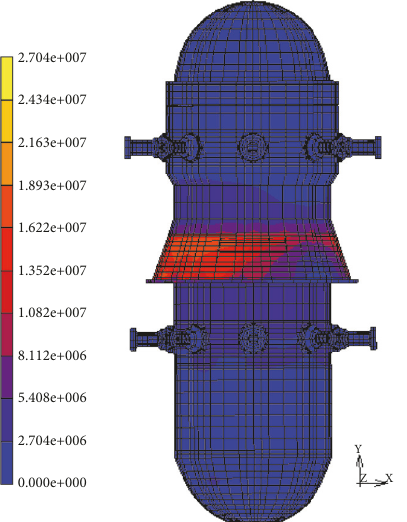
Figure 12: Von Mises stress in the RPV housed in the isolated containment